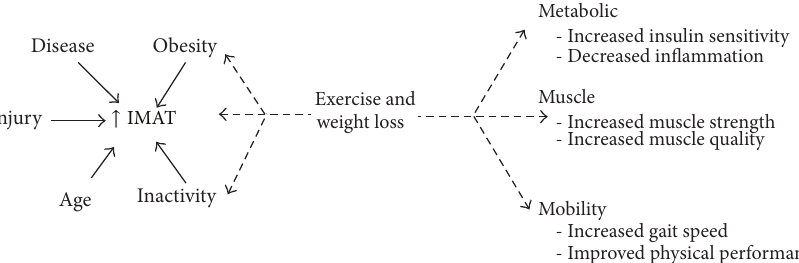
Figure 4: Exercise and weight loss may act to directly decrease IMAT, improve factors associated with increased IMAT such as obesity and inactivity, and improve metabolic, muscle, and mobility